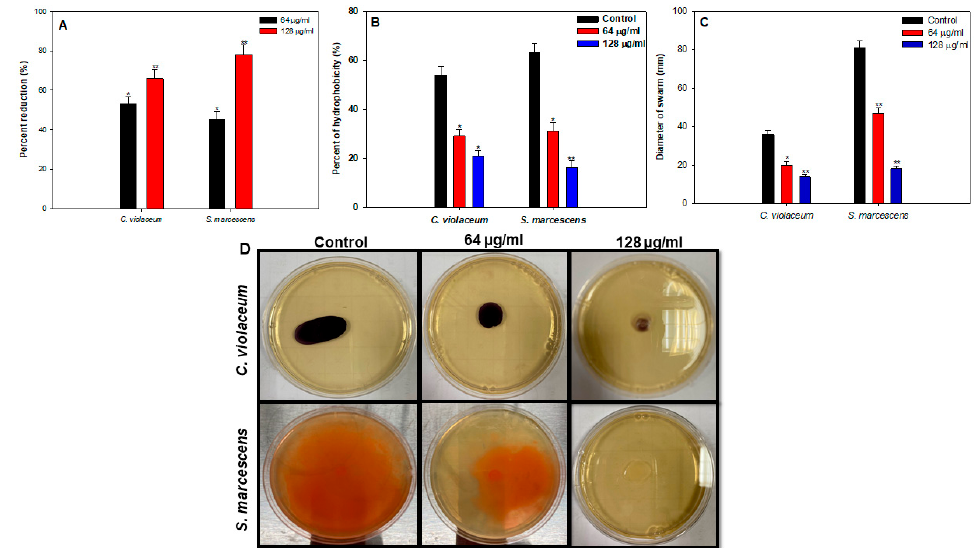
Figure 10. E ff ect of sub-MICs of ZnO@XG on ( A ) EPS production ( B ) cell surface hydrophobicity ( C ) swarming motility in C. violaceum 12472 and S. marcescens ATCC 13880. Data are represented as mean values of triplicate readings, and the bar is the standard deviation. * denotes significance at p ≤ 0.05, and ** denotes significance at p ≤ 0.005. ( D ) plates demonstrating swarming behavior of C. violaceum 12472 and S. marcescens ATCC 13880 in the absence and presence of sub-MIC